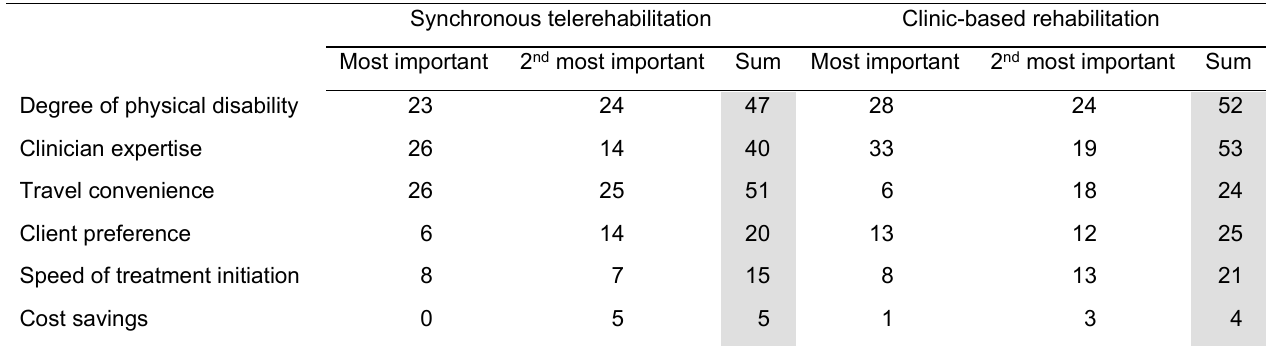
Number of Respondents Identifying Various Factors as Most and Second Most Important when Recommending Synchronous Telerehabilitation versus Clinic-based Rehabilitation Synchronous